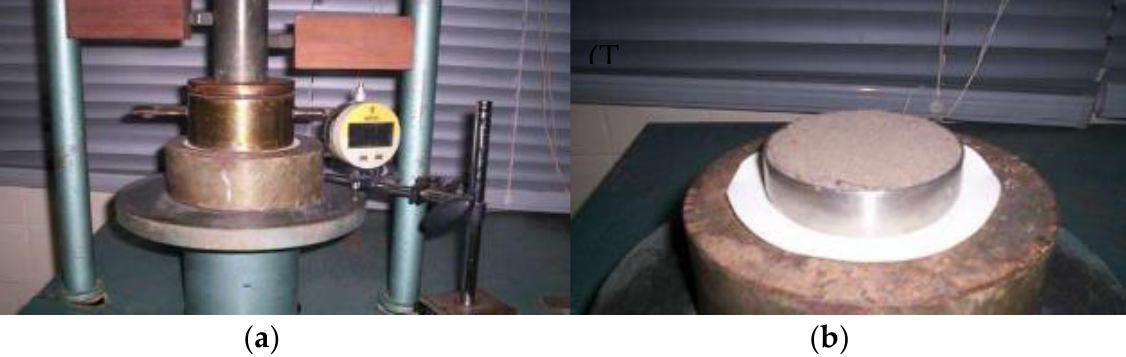
Figure 3. Compression mold at the beginning and after static compression: ( a ) Mold in the press at the start of compaction; ( b ) Mold after compaction.